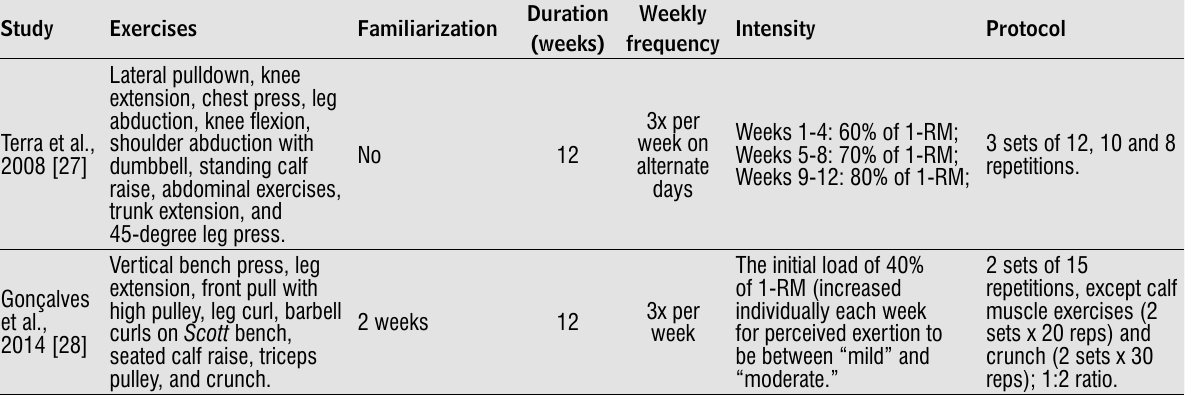
Table 2 – Resistance training protocols of the